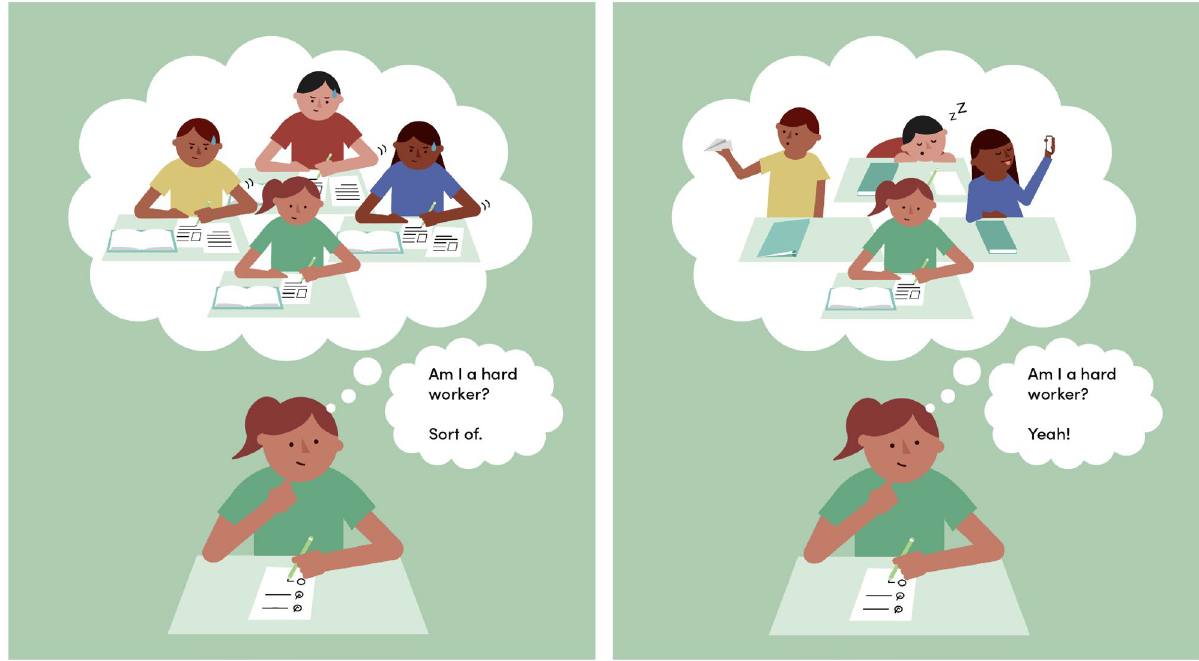
Figure 1. Peers influence the standards by which an individual judges their own behavior, resulting in a “reference bias” effect that distorts cross-context comparisons of self-reported self-regulation. Illustration by Tom